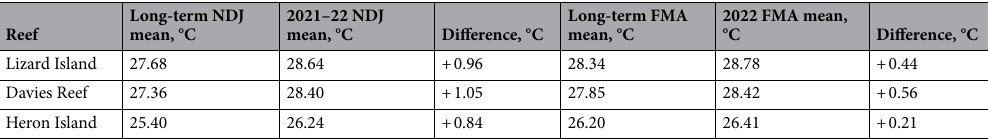
Table 1. Reef scale water temperature for November/December/January (NDJ) and February/March/April (FMA) 2021/2022 compared to long term mean (March 2002–April 2022) and corresponding difference 24 . Lizard Island, Northern GBR; Davies Reef, Central GBR; Heron Island, Southern GBR.